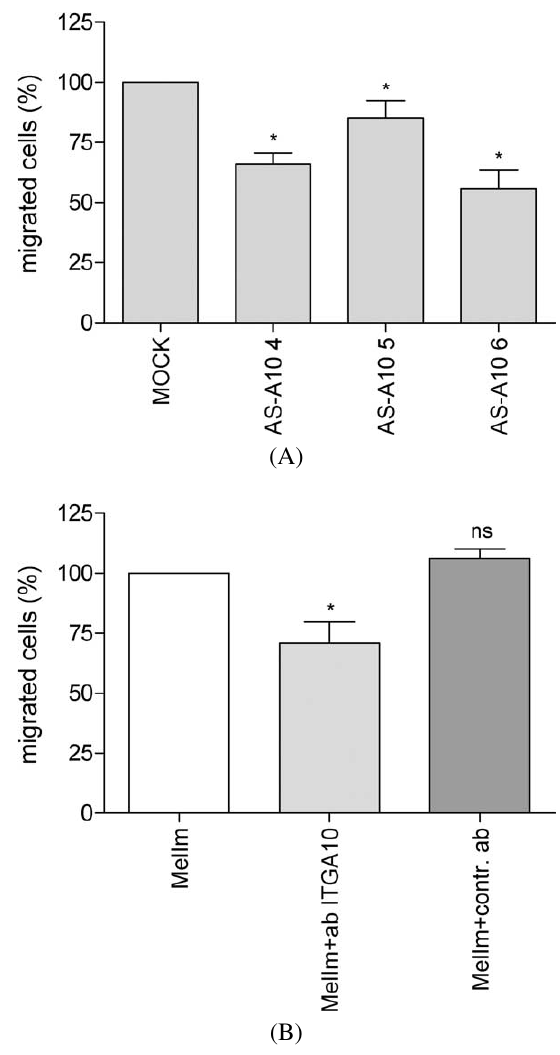
Fig. 6. Effect of reduction of integrin alpha10 on migration and in- vasion. Analysis of the cell clones expressing less integrin alpha10 in Boyden Chamber assays revealed a reduction of the migratory po- tential in the as cell clones in comparison to Mel Im cells and mock control (A). The same effect was shown using an inhibitory antibody against integrin alpha10 while control antibody did not affect the mi- gratory potential (B). There were no significant changes of the in- vasive potential of the as integrin alpha10 cell clones compared to Mel Im cells and the mock control (C). Assays were performed in triplicate (*: p < 0 . 05, ns: not